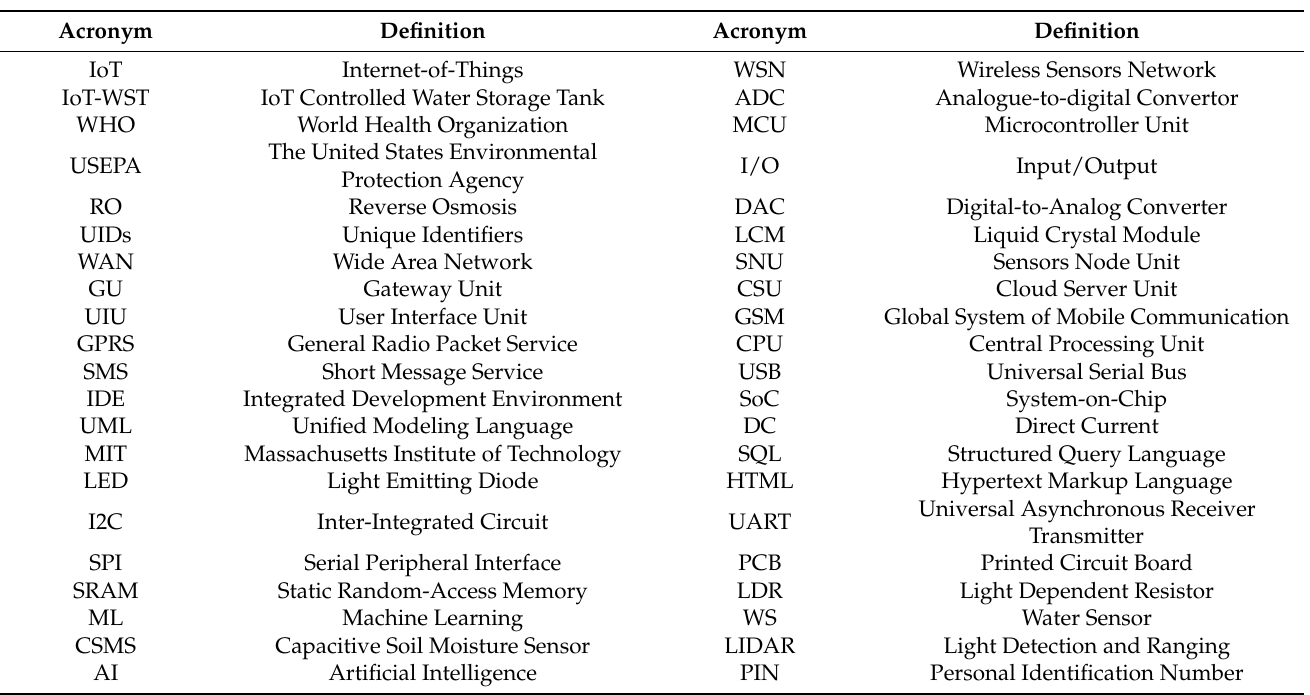
Table 2. Commonly used